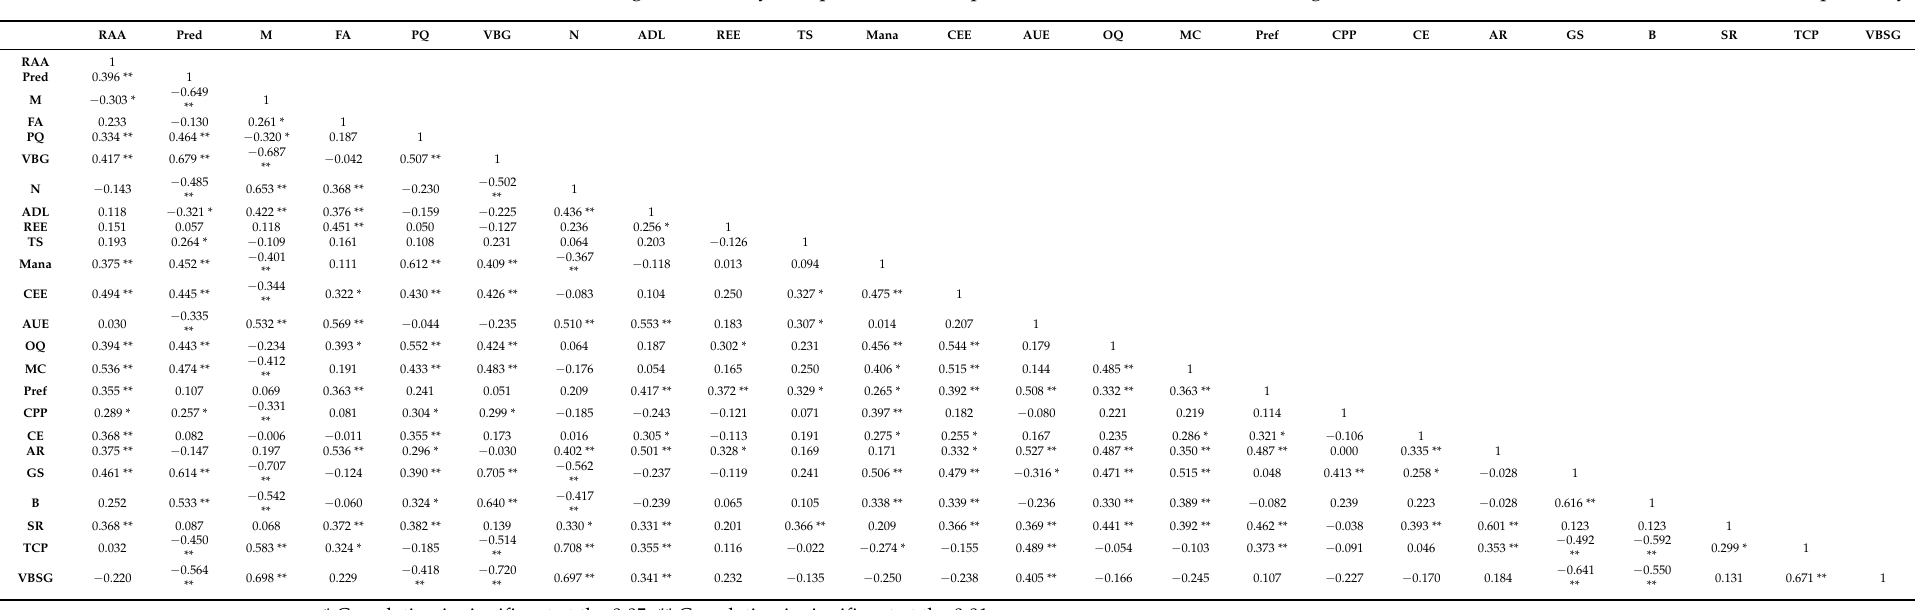
Table A1. Multivariate linear regression analysis report (* and ** represent the correlation which are significant at the 0.05 level and 0.01 level (2-tailed),